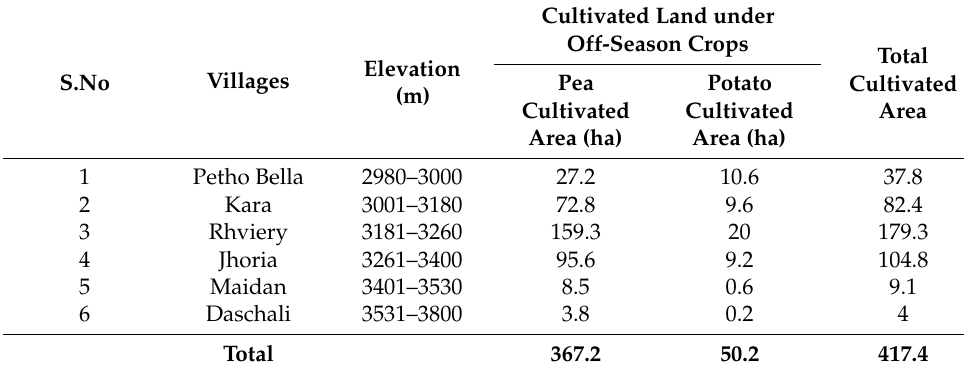
Table 2. Elevation-wise cropland expansion in the study